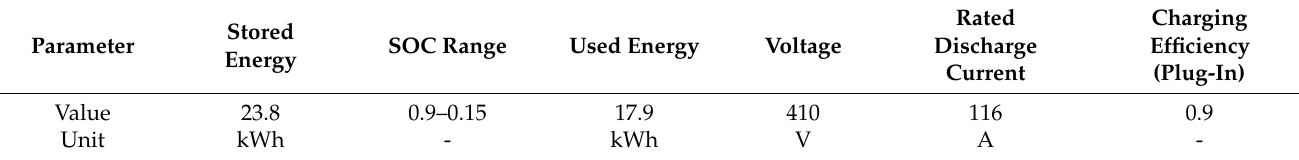
Table 6. Battery pack